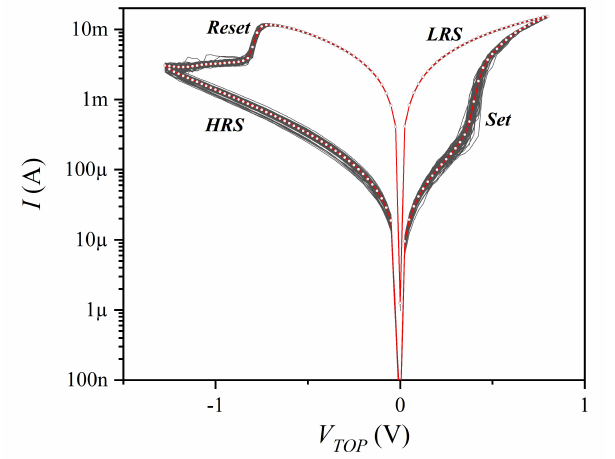
Figure 2. Current–voltage cycles measured at 300 K (black lines) and the 100-cycle average (red